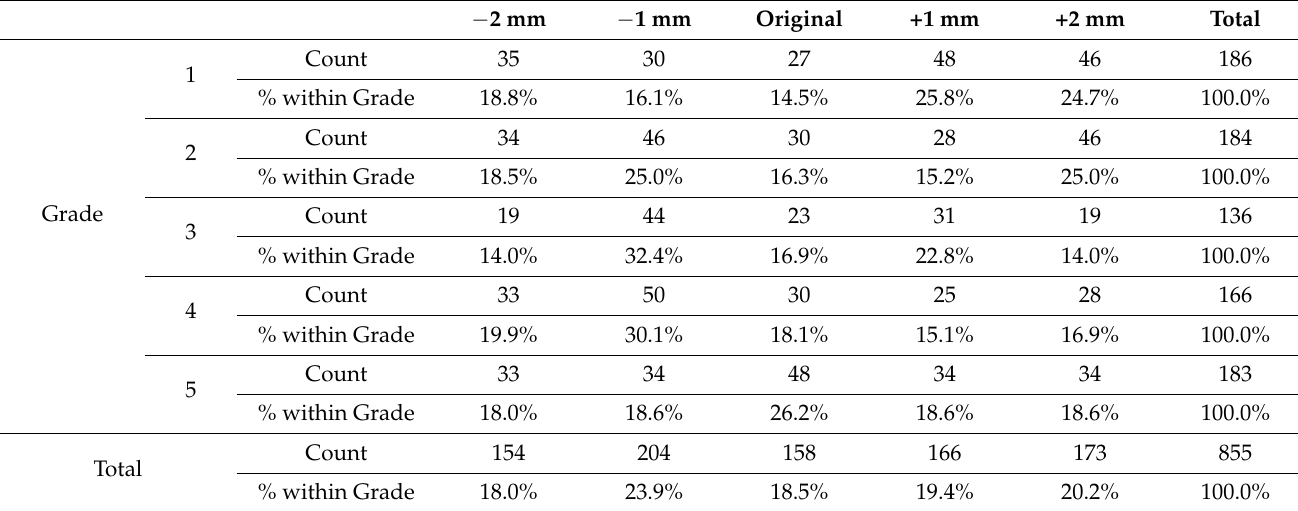
Table 5. Distribution of preferences across grades regarding the simultaneous modifications of the nose and chin (NC, photo series No.